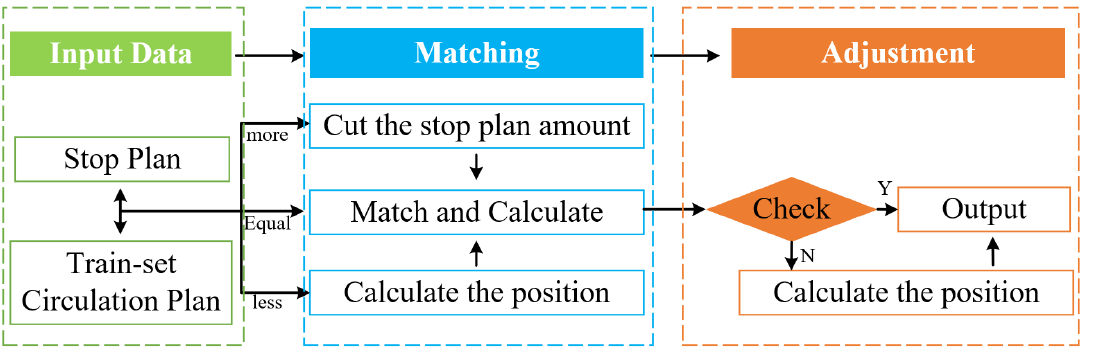
Figure 12. The matching and adjusting method.